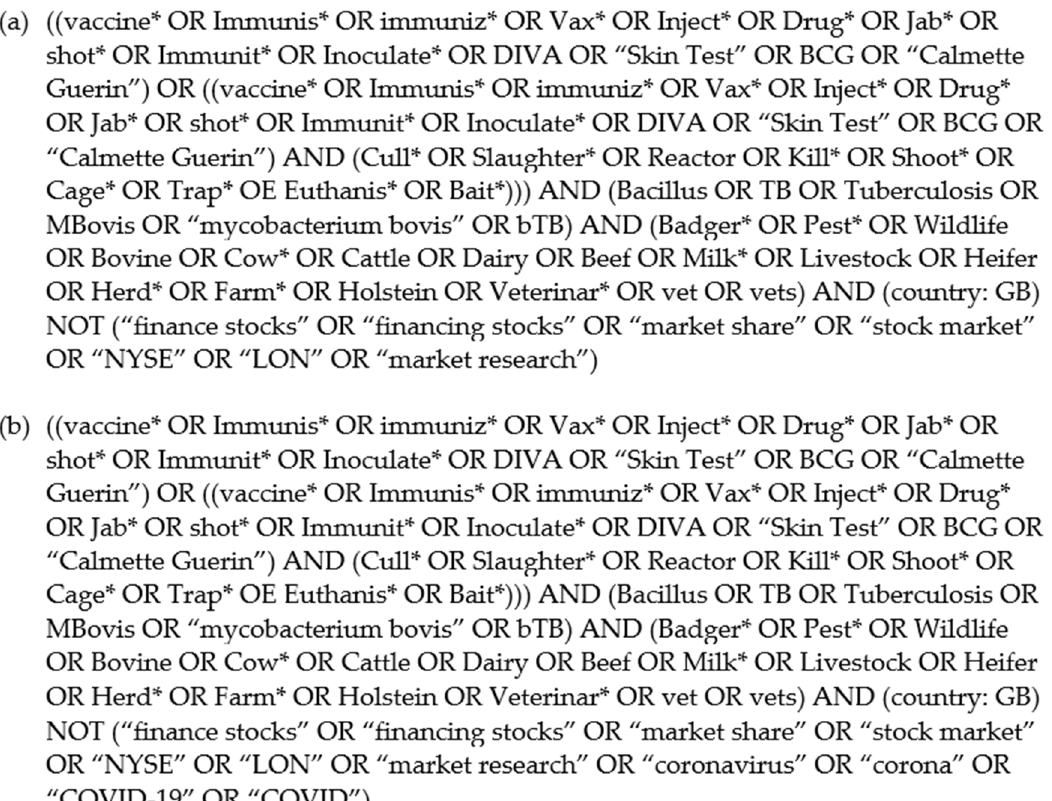
Figure 1. ( a ) Announcement-1 Boolean search. Created for Announcement-1 data collection on the Meltwater platform. This Boolean search was piloted initially to assess data collection prior to use; ( b ) Announcement-2 Boolean search, amended from Announcement-1 considering the surge in COVID-19-related digital and social media posts that were gathered during the first data collection.